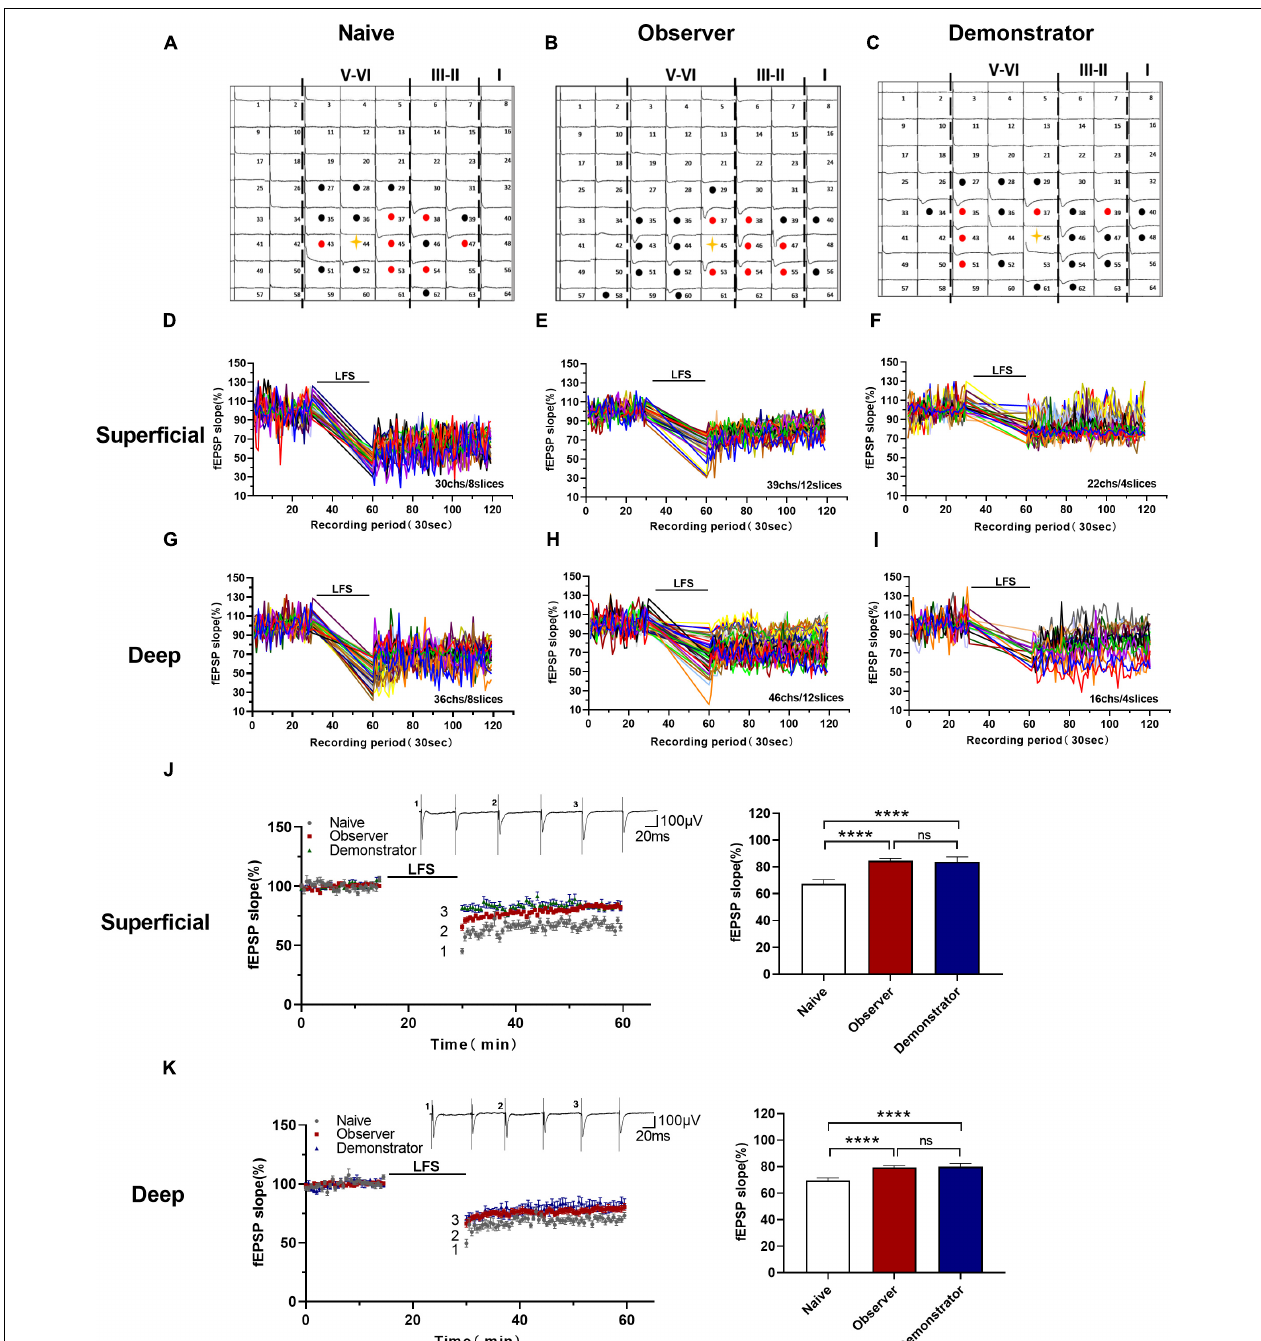
FIGURE 6 | Altered the cortical LTD in the aIC of observer and demonstrator mice. (A–C) Samples of an overview of multisite synaptic responses recorded at baseline (black) and showing LTD after LFS (red) in naïve (A) , observer (B) , and demonstrator mice (C) , respectively. The flash denotes the stimulated channel, red- and black-filled circles mark all activated channels, vertical lines demarcate different layers; (D–I) All channels with LTD in the superficial and deep layers of naïve, observer, and demonstrator mice. (D) 30 channels of 8 slices with LTD in the superficial layers of aIC in naïve mice. (E) 39 channels of 12 slices with LTD in the superficial layers of aIC in observer mice. (F) 22 channels of 4 slices with LTD in the superficial layers of aIC in demonstrator mice. (G) 36 channels of 8 slices with LTD in the deep layers of aIC in naïve mice. (H) 46 channels of 12 slices with LTD in the deep layers of aIC in observer mice. (I) 16 channels of 4 slices with LTD in the deep layers of aIC in demonstrator mice. (J,K) Left: Time course of averaged fEPSP slope of all active channels from the superficial (J) and deep layers (K) of aIC in naïve, observer, and demonstrator mice. The line indicates the time of LFS application in the deep layer V/VI. Right: the average slope and of all active channels within the last 10 min recording in the superficial (J) and deep layers (K) of aIC. Data are shown as mean ± SEM (Naïve n = 8 slices of 7 mice, observer n = 12 slices of 8 mice, and demonstrator n = 4 slices of 4 mice) and compared by one-way ANOVA analysis followed by unpaired t -test, **** p < 0.0001, vs. naïve.